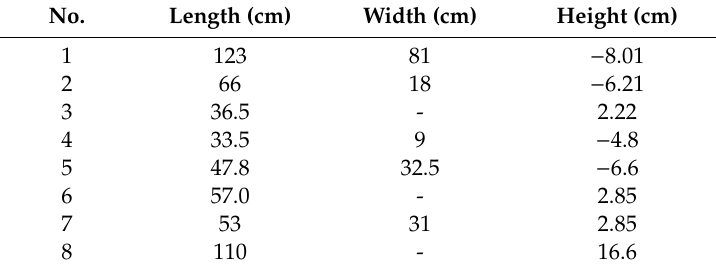
Figure 18. Field measurements. Table 4. Field measurement data.